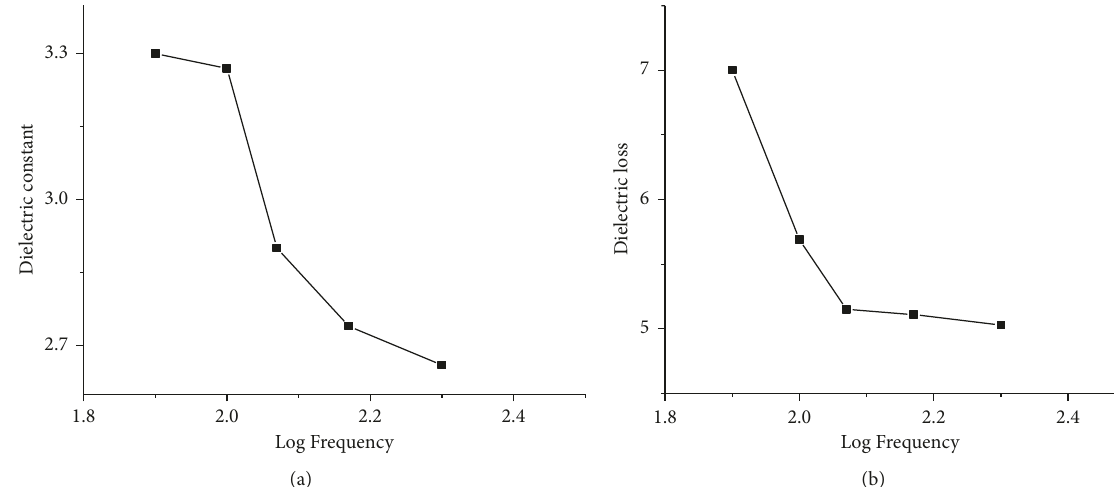
Figure 13: (a) Dielectric constant. (b) A logarithmic change changes with logarithmic frequency in dielectric